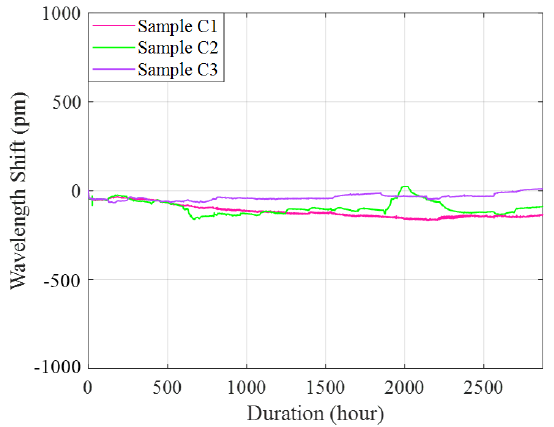
Figure 12. Experimental results from corrosion-only tests. Table 4. Average corrosion rates of three samples.